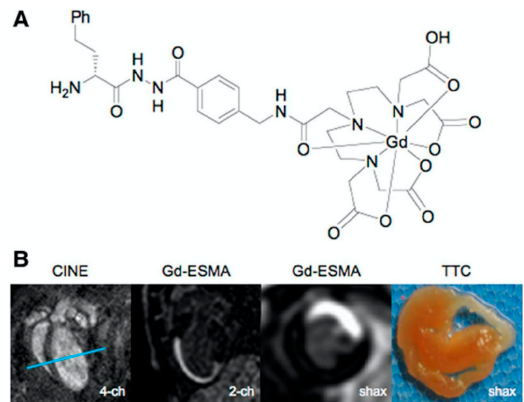
Figure 16. Gadolinium-based elastin-specific MR contrast agent (Gd-ESMA) for imaging of myocardial scar. ( A ), Chemical structure of Gd-ESMA. ( B ), Cross-sectional cardiac MR images of C57BL/6J mouse on postoperative day 7 after myocardial infarction. Two-chamber view and short-axis view obtained at the level of the blue lines in first 4-chamber (image) show accumulation of Gd-ESMA (second and third image) in the myocardial scar, corresponding to the infarct area on triphenyltetrazolium chloride (TTC) staining (last image). Reproduced with permission from Wildgruber et al., 2014 [108].